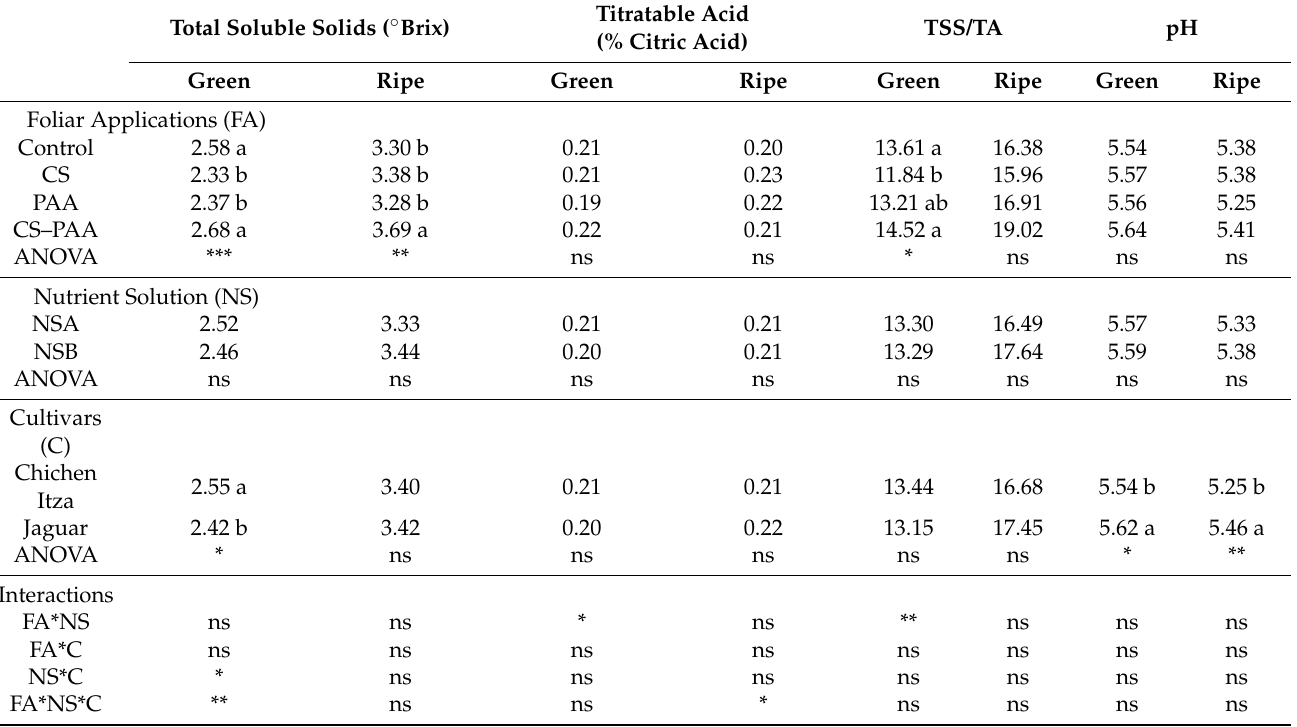
Table 5. Effect of the foliar applications (Control; CS = chitosan; PAA = poly(acrylic acid); and CS–PAA = chitosan–poly(acrylic acid) complexes), nutrient solution (NSA and NSB; see Table 3) and cultivars (Chichen Itza hybrid and Jaguar variety) as well as their interactions on total soluble solids, titratable acid, TSS/TA ratio and pH measured in green and ripe fruits.